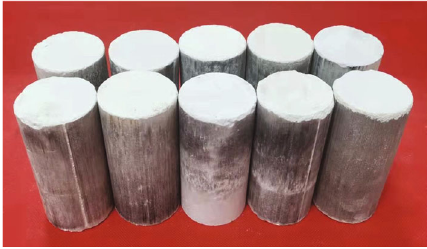
Figure 3: Some weakly cemented rock